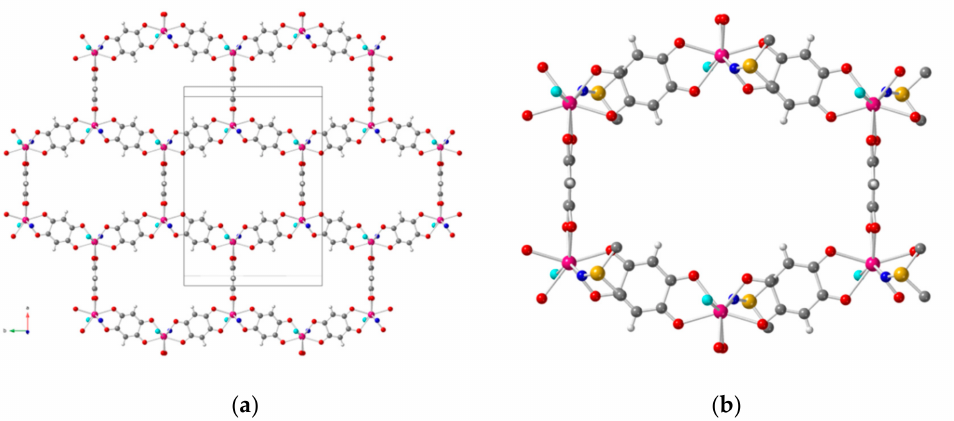
Figure 2. ( a ) Top view of one distorted honeycomb (3,6)-gon layer in 1 (Only the O atom of the coor- dinated dmso molecules is shown, for clarity); ( b ) View of one hexagonal ring in compound 1 . Colour code: Dy = pink, C = grey, S = yellow, H = white, O anilato = red, O water = light blue, O dmso = dark blue. H atoms (except for the dhbq 2 − ligands) and crystallization dmso molecules have been omitted for